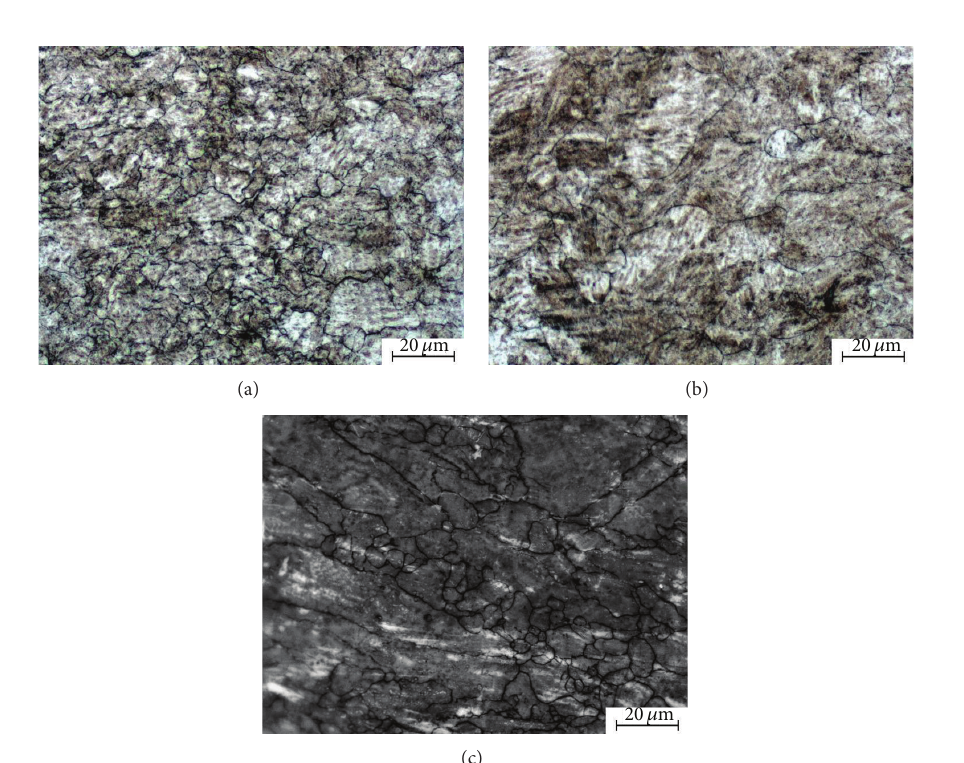
Figure 11: The microstructure of specimens deformed at (a) T = 1000 ∘ C, ̇𝜀 = 0.1 s −1 , (b) T = 1100 ∘ C, ̇𝜀 = 0.1s −1 , and (c) T = 1000 ∘ C, ̇𝜀 = 10 s −1